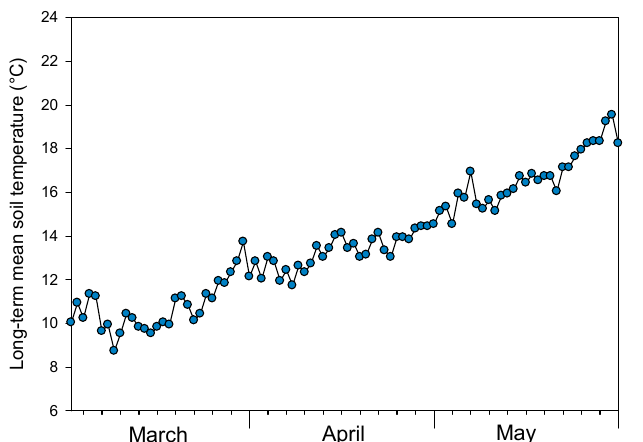
Figure 5. Mean soil temperatures recorded over the 10-year period of 2004–2015 in the 2010 field experimental site.